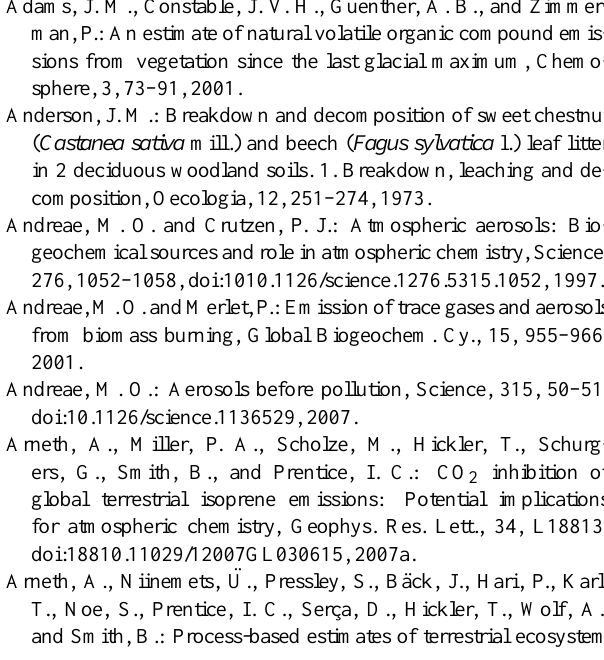
Figure 1 is adopted from P. Artaxo, unpublished. N. Gedney, M. Sanderson and S. Sitch were supported by the Joint DECC and Defra Integrated Climate Programme – DECC/Defra